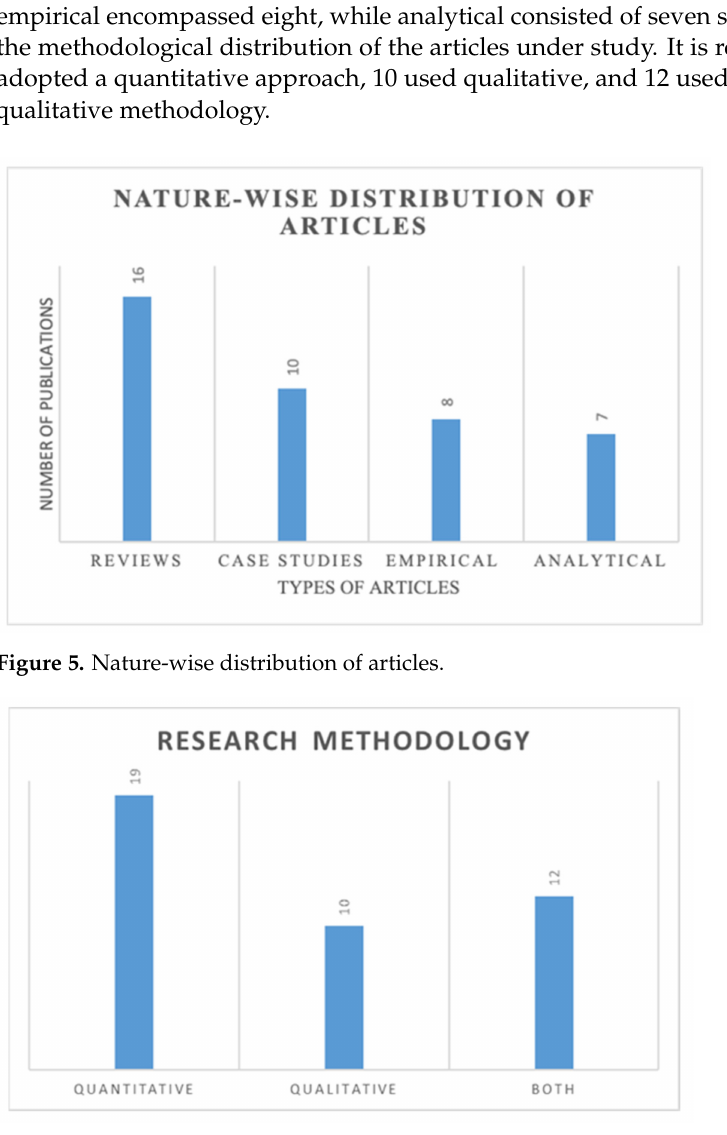
Figure 6. Distribution of adopted